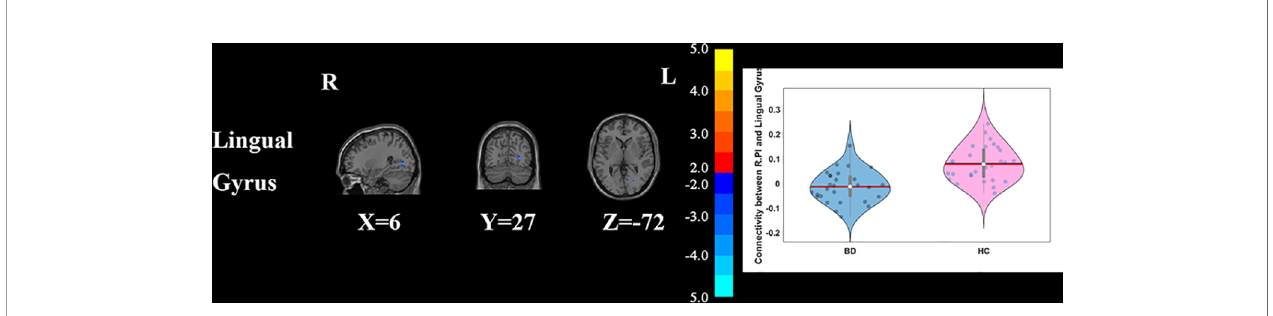
FIGURE 4 | Group differences of the whole brain functional connectivity anchored in R_PI: BD patients had signi fi cantly decreased functional connectivity between R_PI and lingual gyrus (GRF corrected, p < 0.05, voxel Z value > 2.3). Blue indicates smaller values in BD. L, left; R, right; BD, bipolar disorder; HC, healthy control; R_PI, right posterior insula; GRF, Gaussian random fi eld.